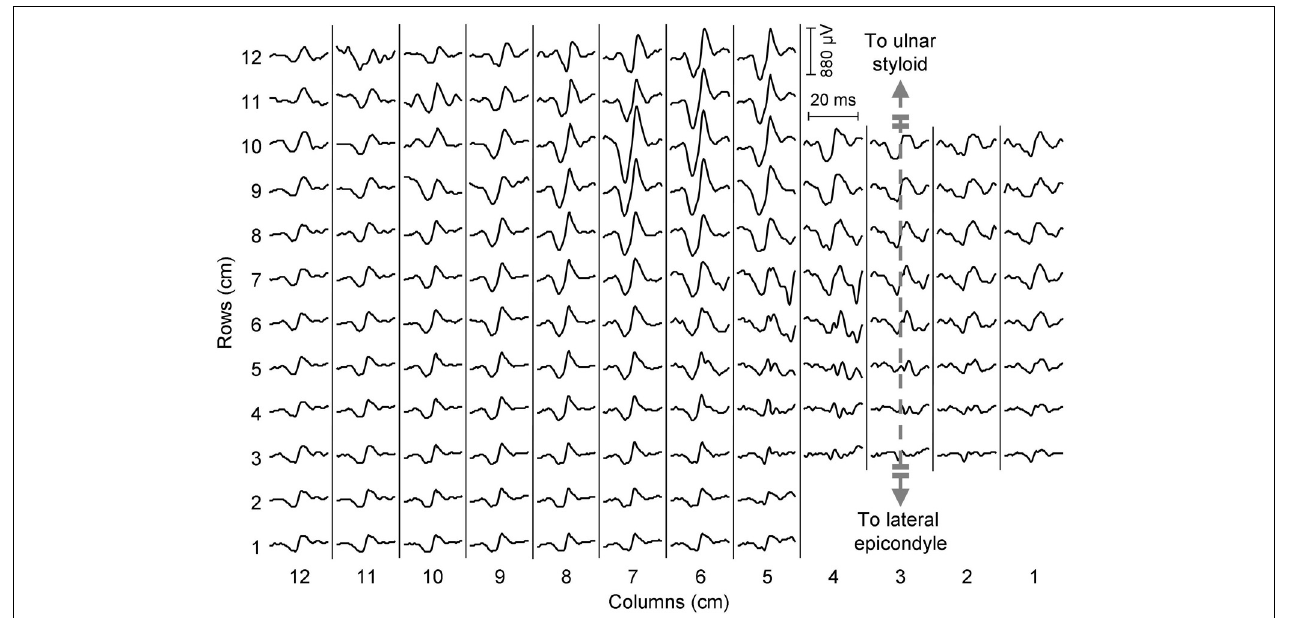
FIGURE 2 | Epoch of EMG signals from a representative subject during a 20% MVC contraction (wrist extension). A motor unit action potential centered in the distal portion of the grid can be observed.